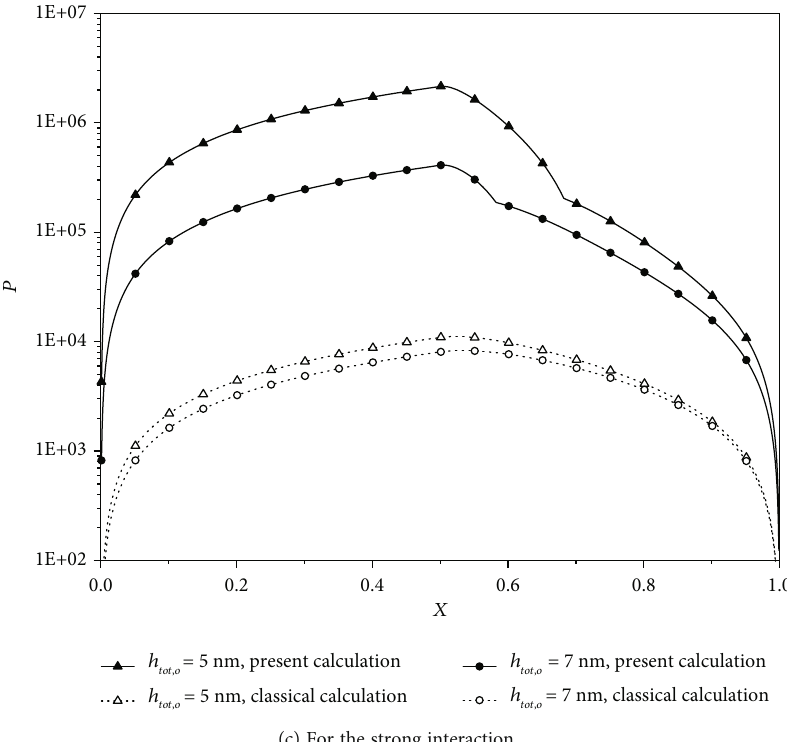
Figure 10: Dimensionless hydrodynamic pressure distribution in the present model of the bearing. Solid line denotes the present numerical calculation, and dashed line denotes the calculation from the classical hydrodynamic theory